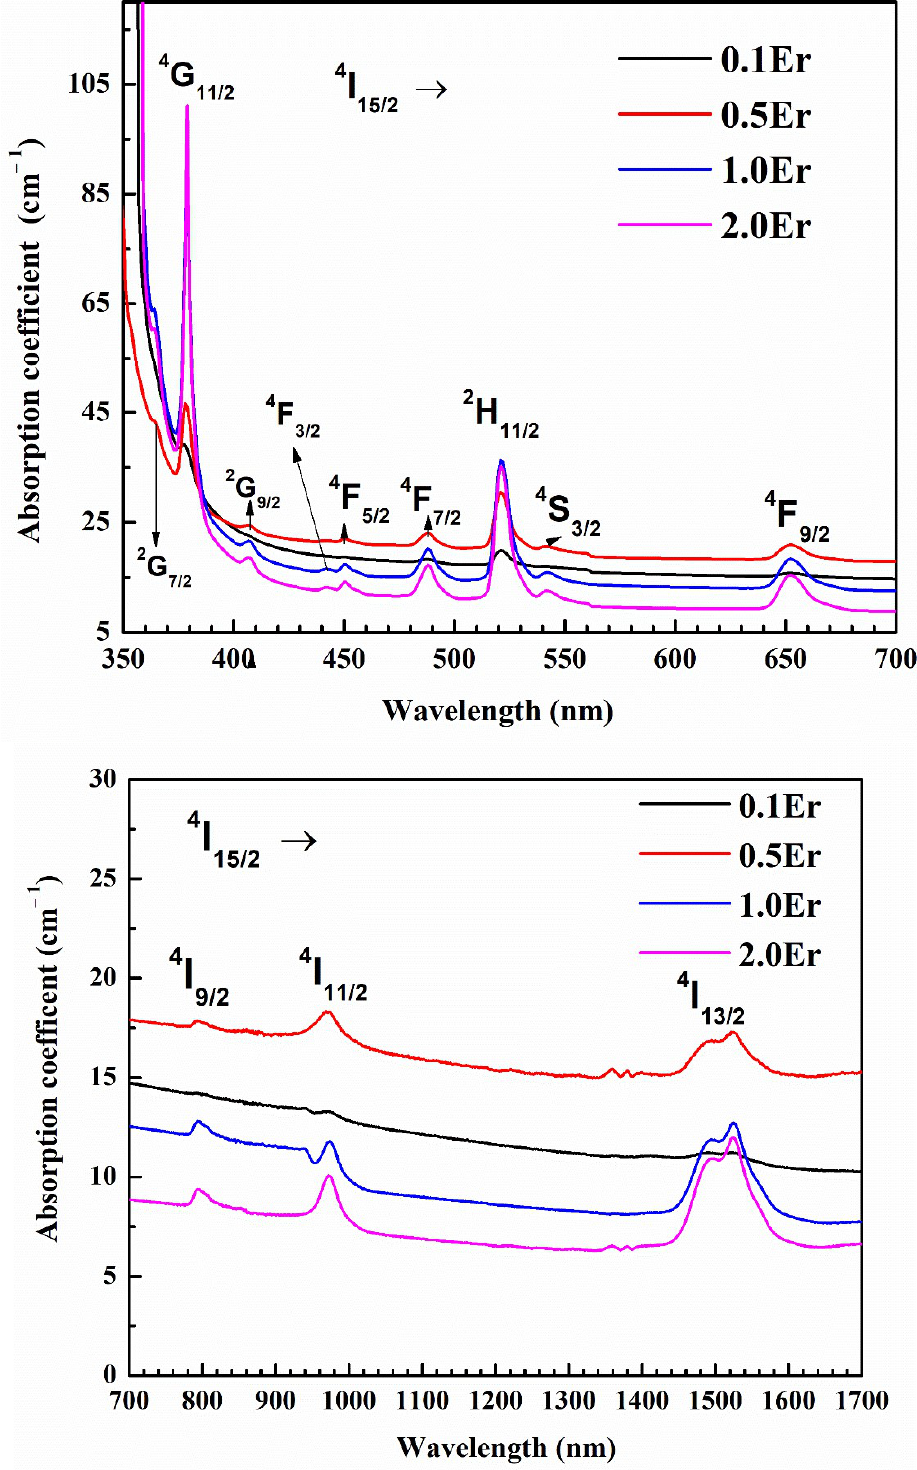
Figure 3. Optical absorption spectra of UV-vis (350–700 nm) ( upper ) and NIR (700–1700 nm) ( lower ) of Er 3+ singly activated ZBB glasses.